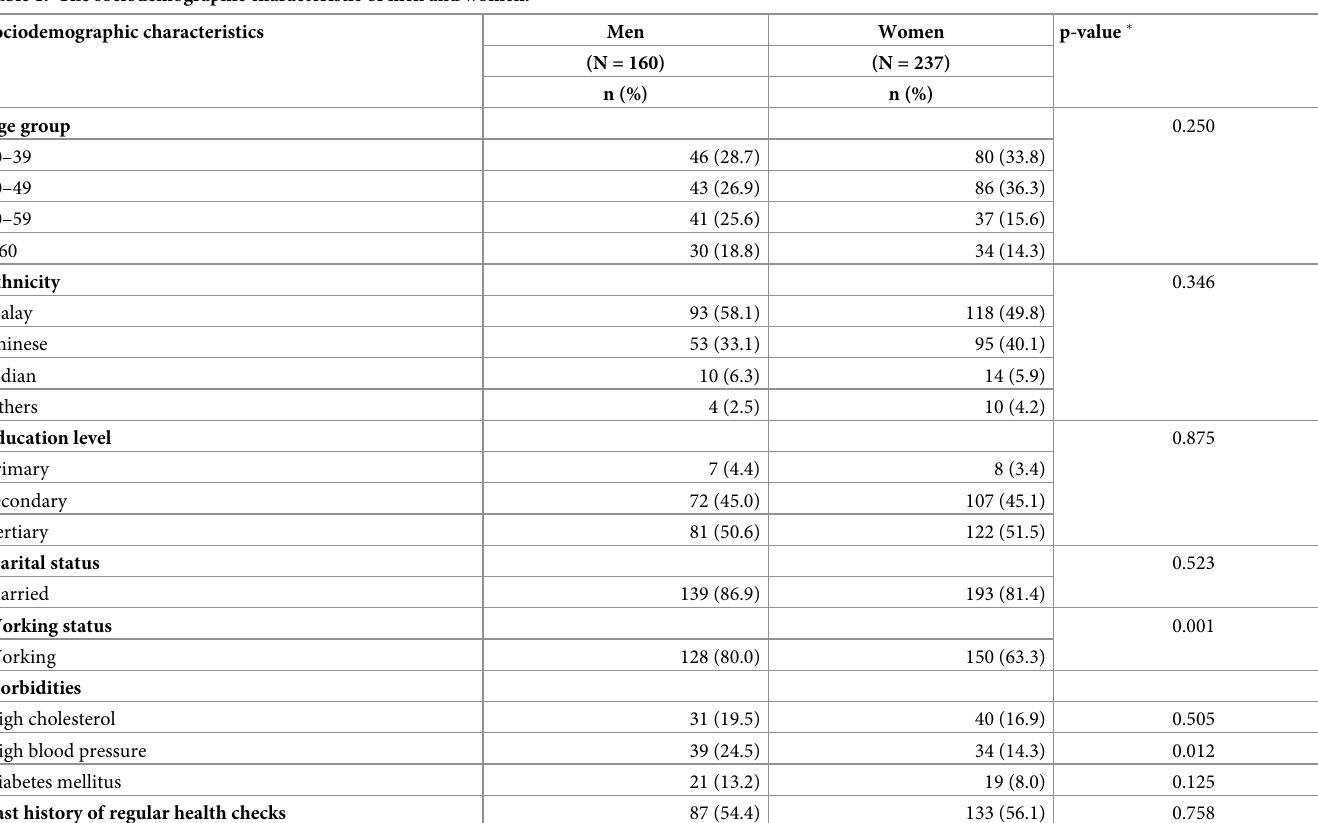
Table 1. The sociodemographic characteristic of men and women. Sociodemographic characteristics